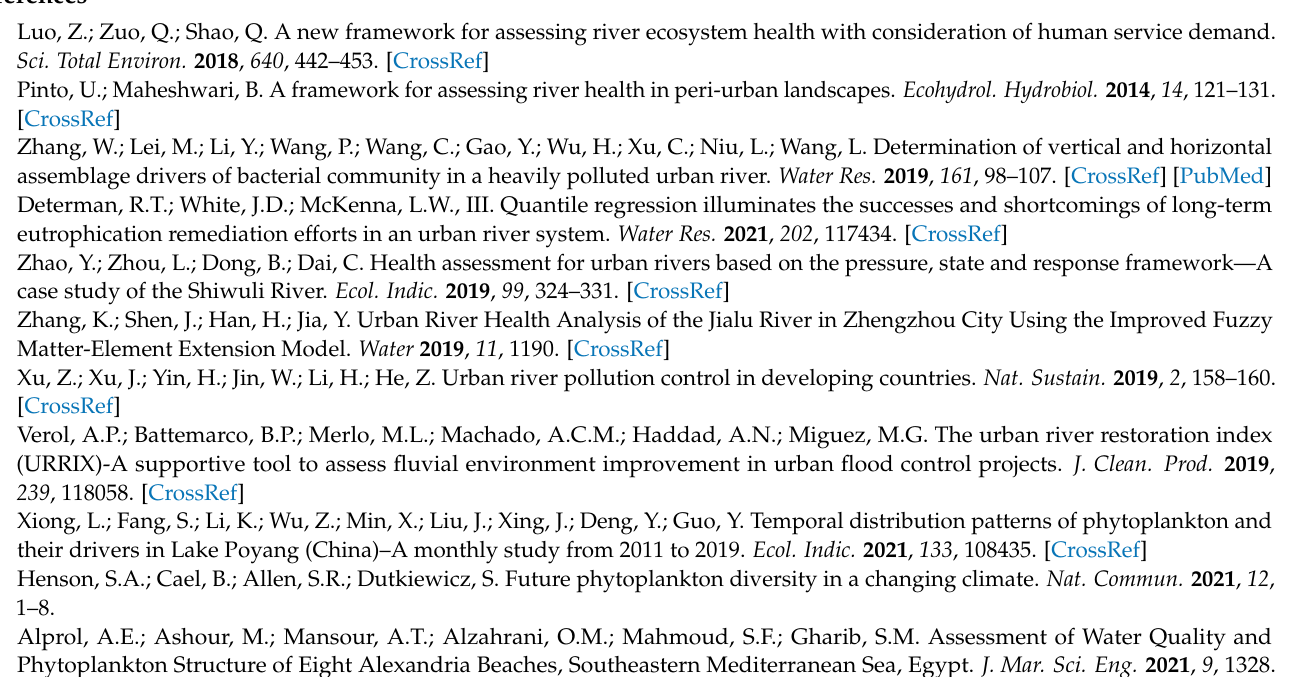
Materials. Figure S1: Boxplots of 15 candidate metrics between the reference site and impaired sites in spring; Table S1: Candidate metrics for the phytoplankton index of biotic integrity (Phyto–IBI); Table S2: Candidate metrics for the zooplankton index of biotic integrity (Z–IBI); Table S3: Weights and normalization factors of the parameters used in the WQI; Table S4: Correlation analysis among 15 candidate metrics in spring; Table S5: Water quality parameters of Yitong River in different